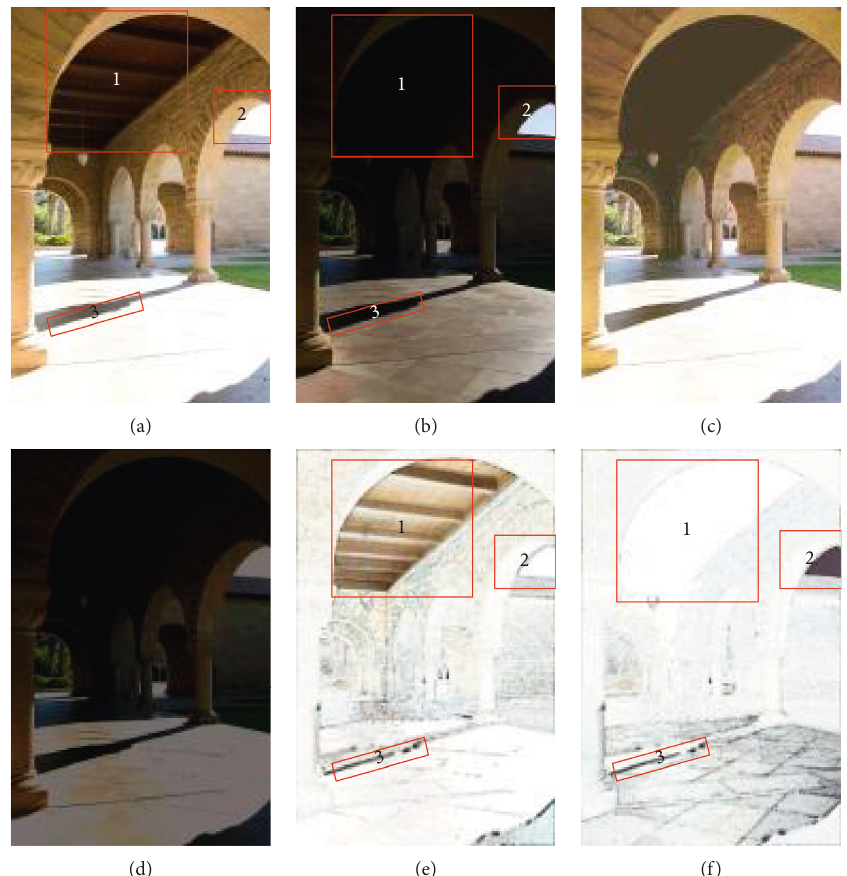
Figure 2: Example of FPSS and BPSS of two images. (a) Reference image; (b) source image; (c) backward-projected image of (b); (d) forward-projected image of (a); (e) BPSS; (f)